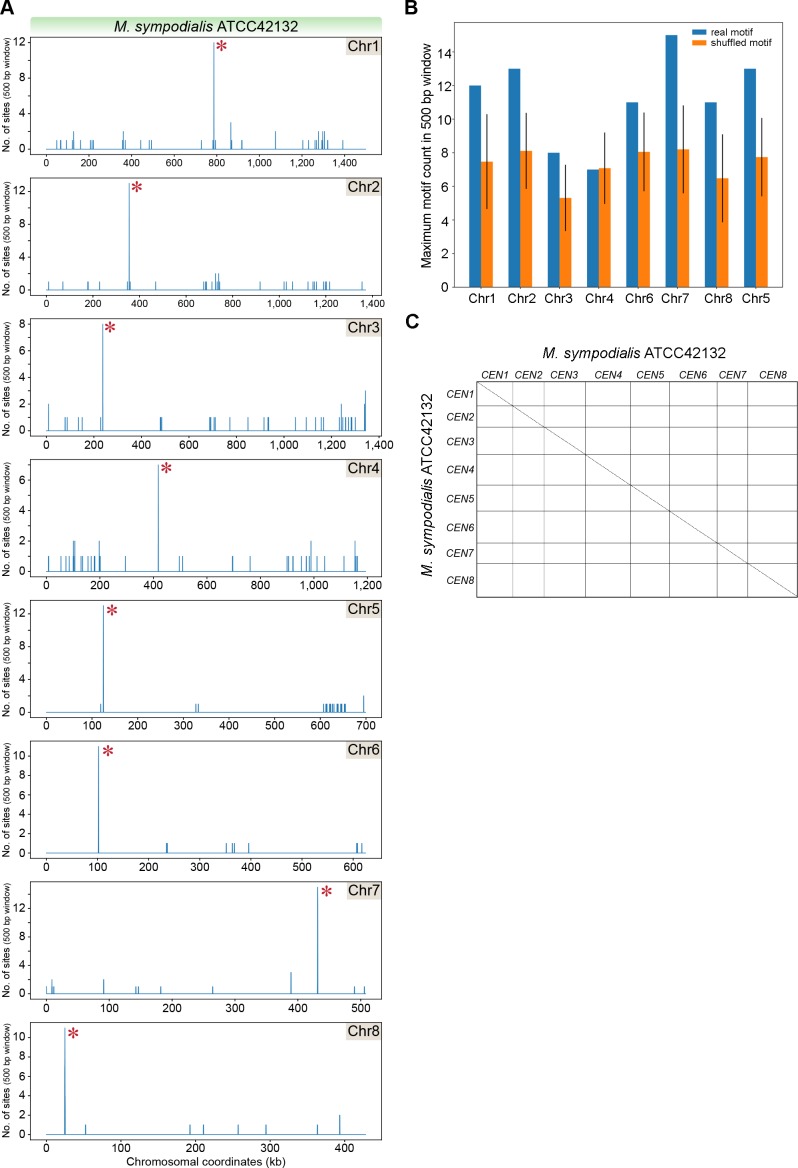
Sequence features of centromeres in M. sympodialis.(A) The genome of M. sympodialis was scanned for matches to the 12-bp AT-rich motif using a 500 bp sliding window. Hit counts (y-axis) were plotted against the chromosomal coordinates (x-axis, in kb). Red asterisks near the line corresponding to maximum enrichment in every chromosome mark the regions predicted as centromeres. (B) Comparison of the maximum motif counts in a 500-bp window in each M. sympodialis chromosome (y-axis) estimated with the position weight matrix (PWM) of the 12 bp motif (blue bars, labeled real) and a scrambled version of the matrix (orange bars, labeled shuffled). The x-axis indicates individual chromosomes in M. sympodialis. (C) A dot-plot generated by plotting sequences that include 5 kb flanking the Mtw1-enriched regions in M. sympodialis against themselves is depicted. The coordinates of regions used in M. sympodialis are: CEN1, 781716–791716; CEN2, 350852–360852; CEN3, 232777–242777; CEN4, 413320–423320; CEN5, 120251–130251; CEN6, 97796–107796; CEN7, 426611–436611; and CEN8, 19905–29905.